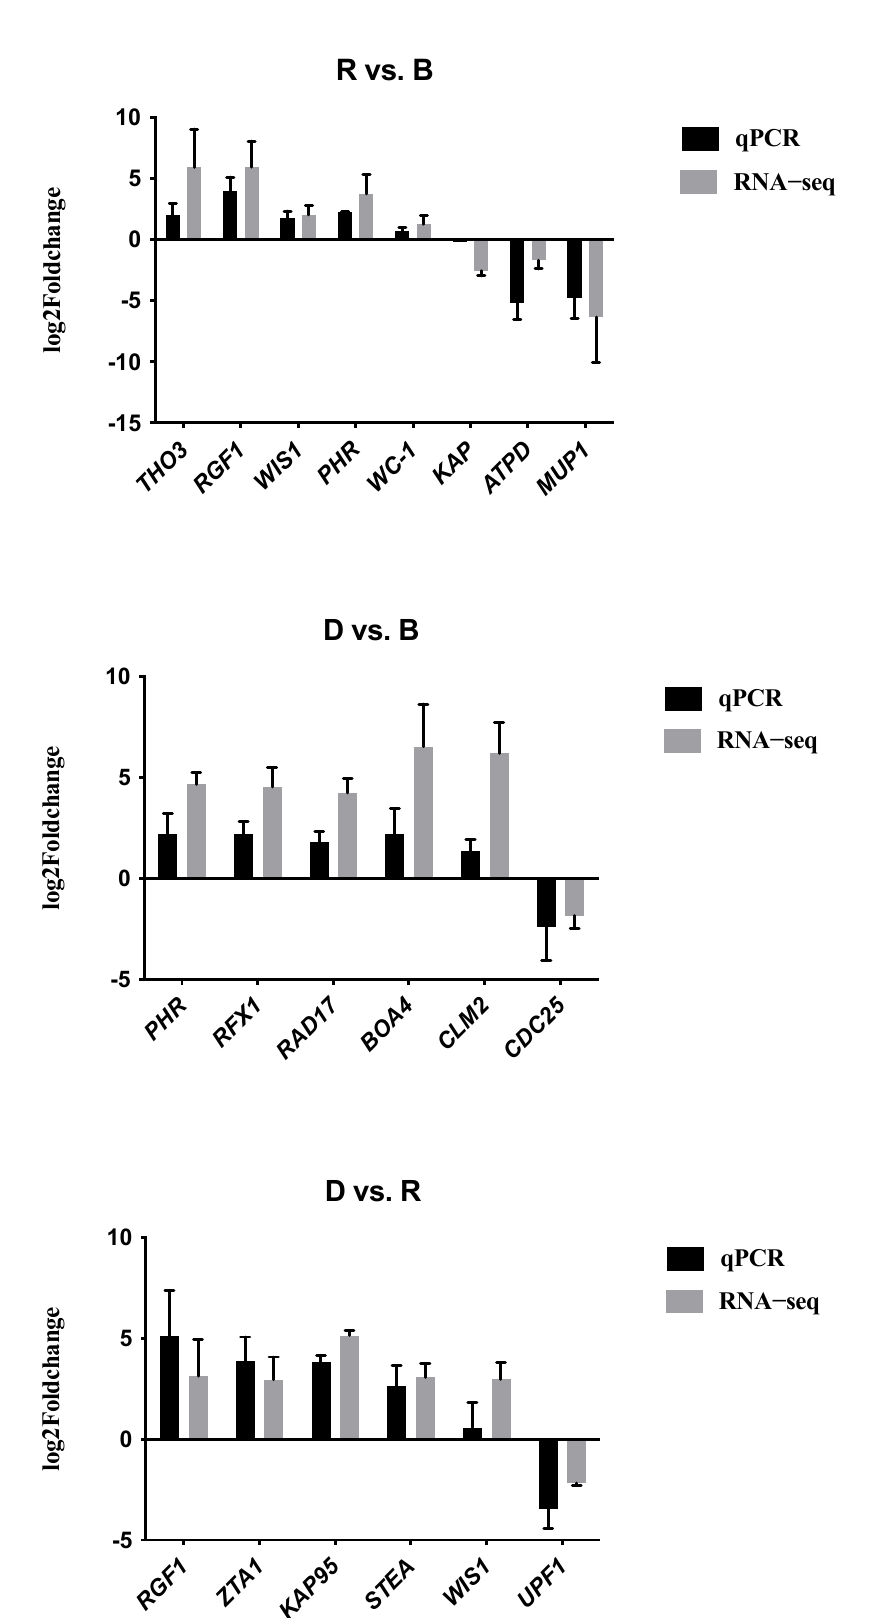
Figure 11. RT-qPCR validation. The X-axis shows the names of the DEGs. The left Y-axis shows the logarithm of the relative expression level. Error bars indicate the standard deviations of three biological replicates of RT-qPCR analysis.